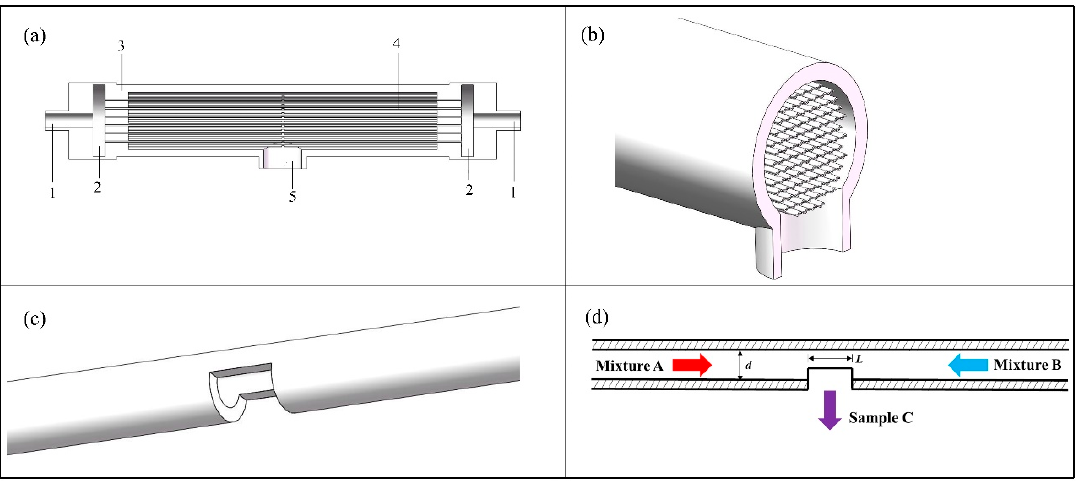
Figure 1. C-CFMCR: ( a ) appearance of C-CFMCR: 1. main inlet; 2. buffer zone; 3. shell; 4. S-CFMCRs; 5. main outlet; ( b ) middle cross-section of C-CFMCR.; ( c ) S-CFMCR; ( d ) schematic illustration of S- CFMCR.